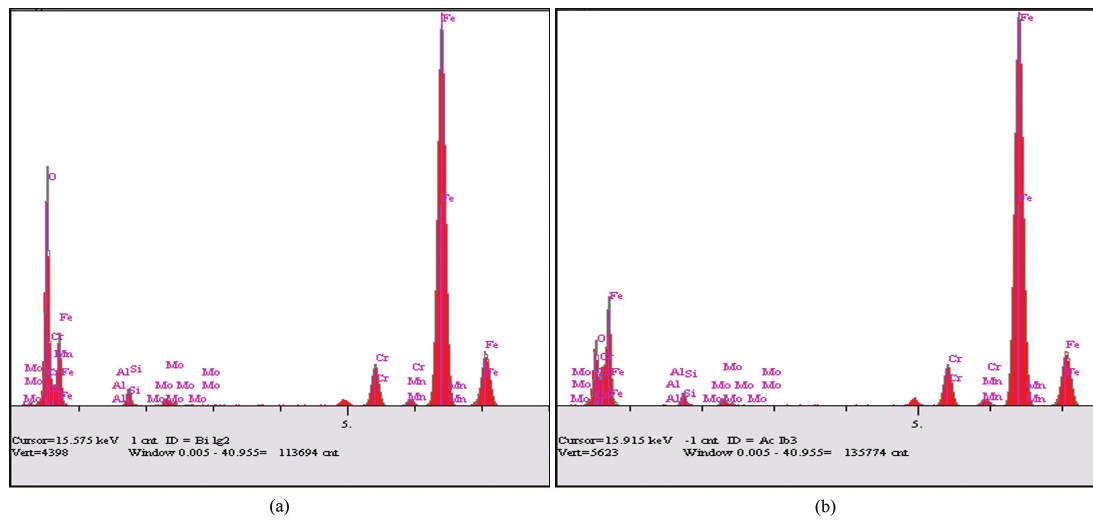
Figure 12. Spectrum of non-nitrided AISI H13 referring to the region (a) region 1 and (b) region 2.